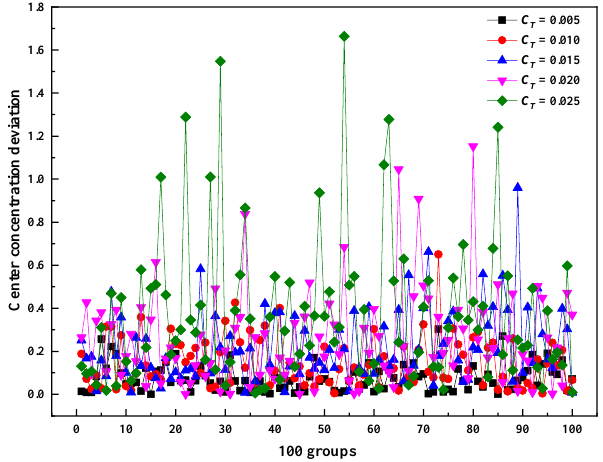
Figure 7. Center concentration deviation under different relative standard deviations of temperature at mean temperature 563 K.